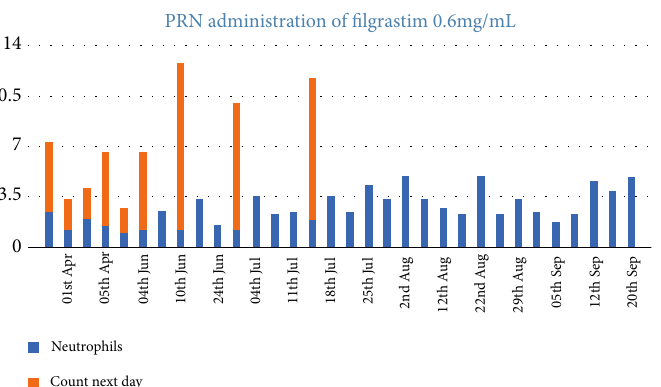
Figure 3: Administration of fi lgrastim resulting in increases in neutrophil levels. Figure 3 demonstrates the administration of fi lgrastim 30MU, given as needed in response to neutropenia occurring from March 2019, in keeping with the patient speci fi c protocol supported by hematology. The x axis shows the timeline of the fi lgrastim administration, and the y axis displays the absolute neutrophil count × 10 9 /L. The blue columns represent the ANC prior to giving fi lgrastim, and the orange columns represent ANCs one day post fi lgrastim administration. Green light results indicating safe ANCs are seen from July 2019 utilizing prophylactic fi lgrastim up to three times